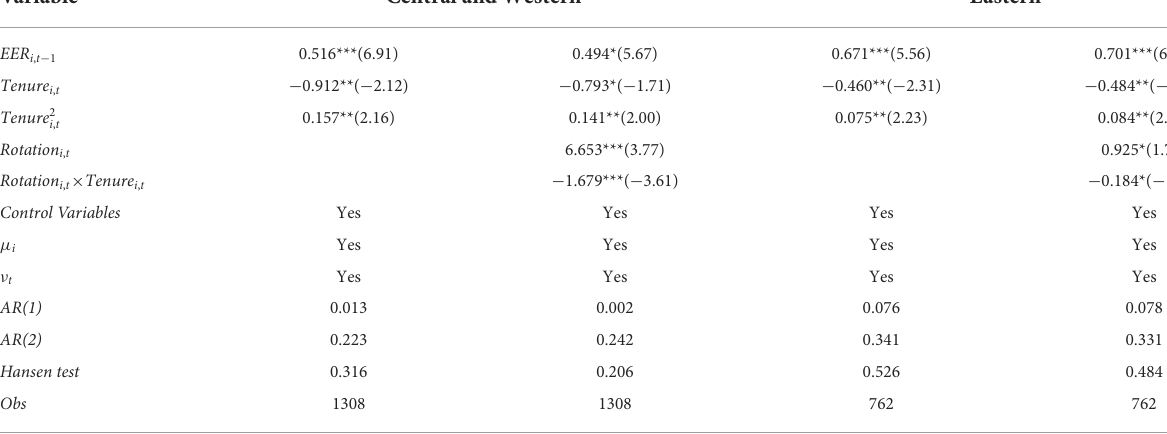
TABLE 4 Empirical results of official compliance heterogeneity I.